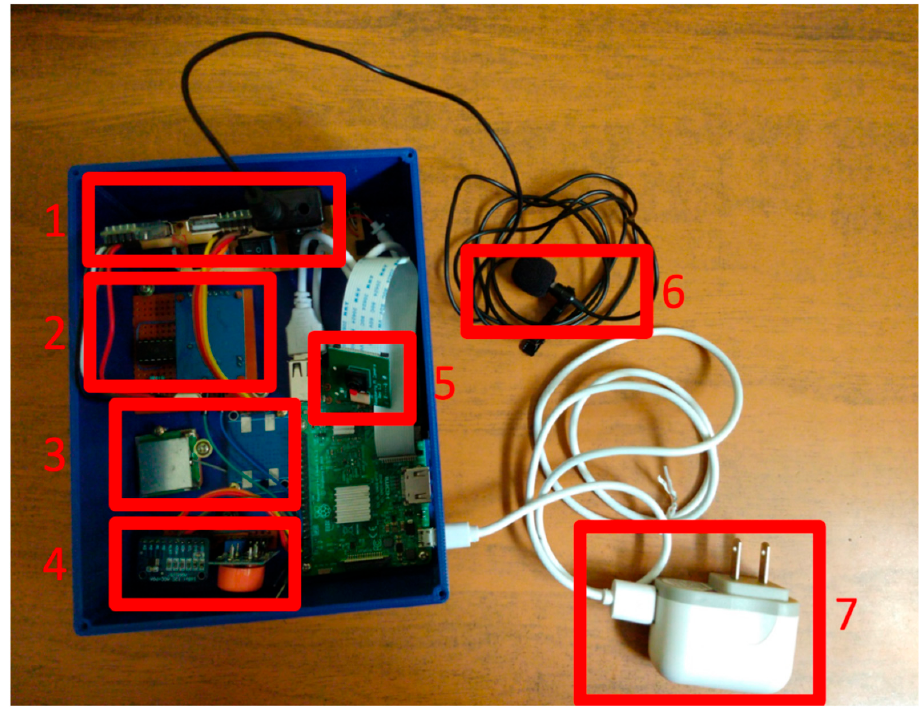
Figure 7. The car’s black box system testbench: 1 is the audio module; 2 is the module for communicating with the ECU; 3 is the GPS module; 4 is the MQ3 module; 5 is the camera module; 6 is the microphone; and 7 is the dc power. Table 1. The number of files and data for each parameter measured over a 10 min journey. Parameters